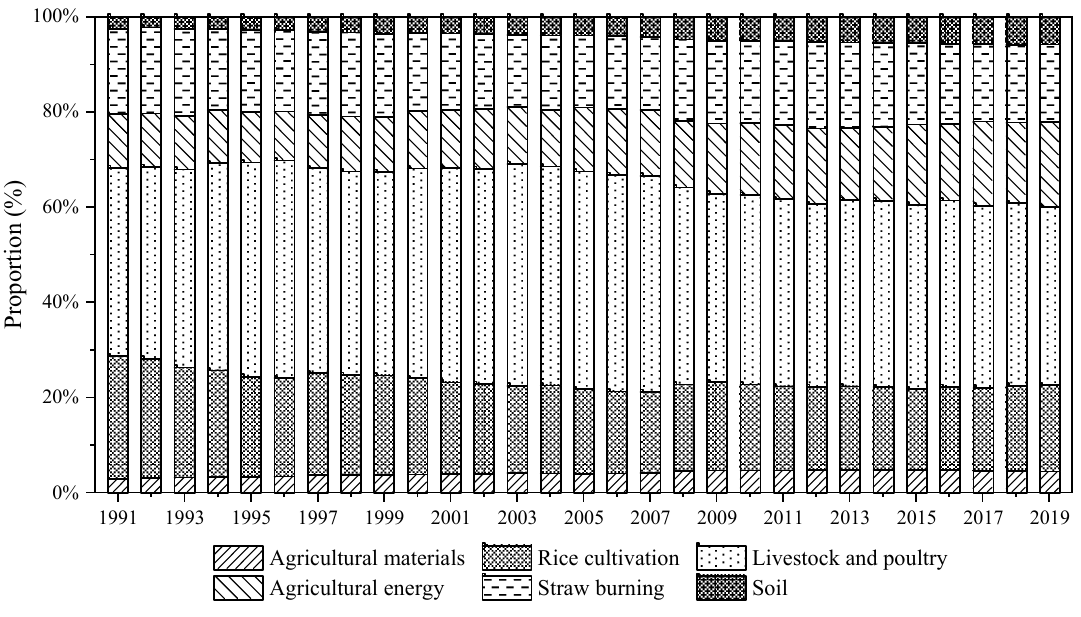
Figure 4. Differences and trends of agricultural carbon emission structure in China, 1991–2019.